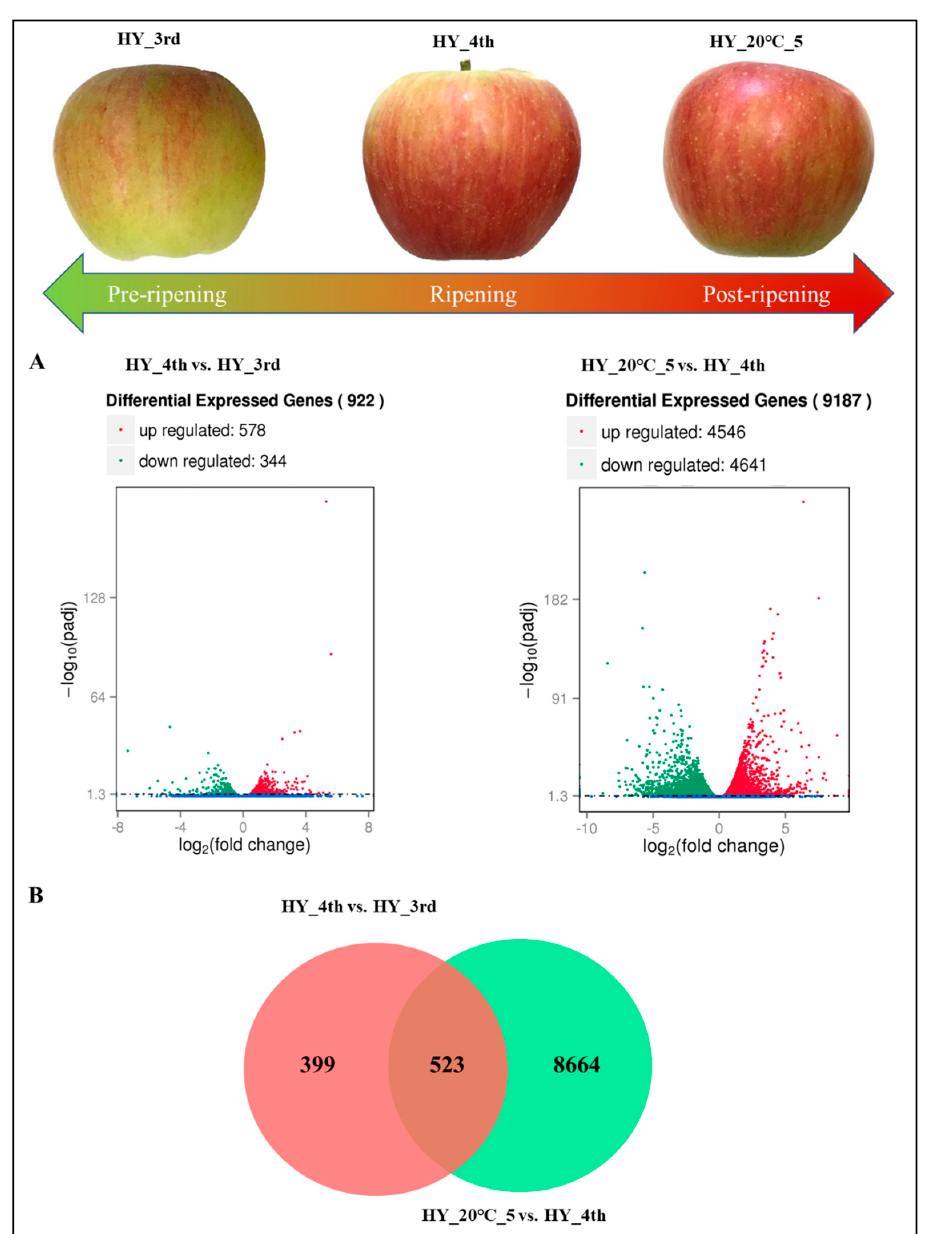
Figure 2. The number of differentially expressed genes (DEGs) within pre ‐ (HY_4th vs. HY_3rd) and post ‐ ripening (HY_20 °C_5 vs. HY_4th) groups ( A ). Overlapped DEGs were shown by Venn diagram between different groups ( B ).